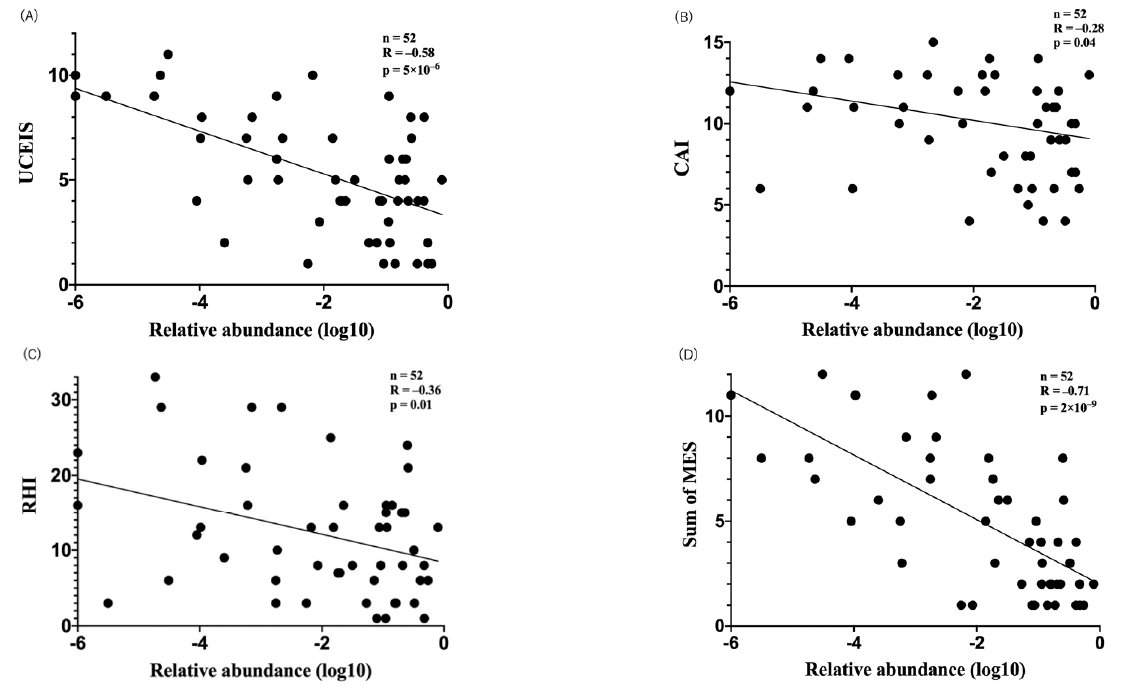
Figure 1. Correlation between the cumulative relative abundance of five key Bacteroidetes species and clinical evaluation. The cumulative relative abundance of five key Bacteroidetes species was correlated with UCEIS (R = − 0.58, p = 5 × 10 − 6 ) ( A ), CAI (R = − 0.28, p = 0.04) ( B ), RHI (R = − 0.36, p = 0.01) ( C ), and the sum of MES (R = − 0.71, p = 2 × 10 − 9 ) ( D